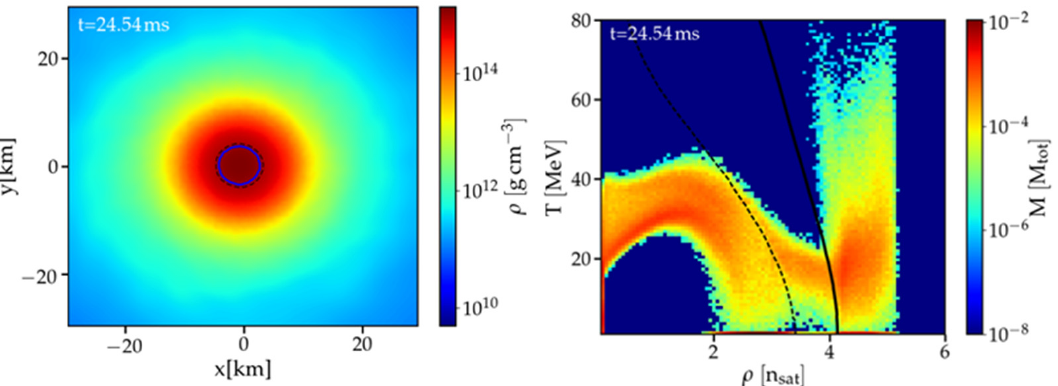
Figure 5. Simulation of a merger of two neutron stars each with 1.35 solar masses based on an EOS with a 1st order phase transition. Left: Rest mass density in the equatorial plane. The black dashed line and the solid blue line surround the regions of phase coexistence and quark matter, respectively. Right: Rest mass distribution as a function of density and temperature plane normalized to the total mass of the system. The black dashed line illustrates the onset of the hadron-quark phase transition. The solid black line is the boundary of the pure quark matter phase. Taken from [28].